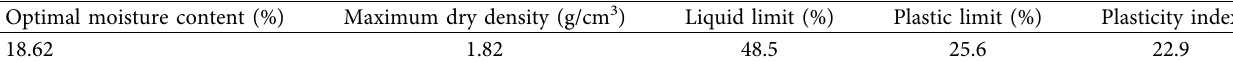
Table 2: Basic parameters of the soil